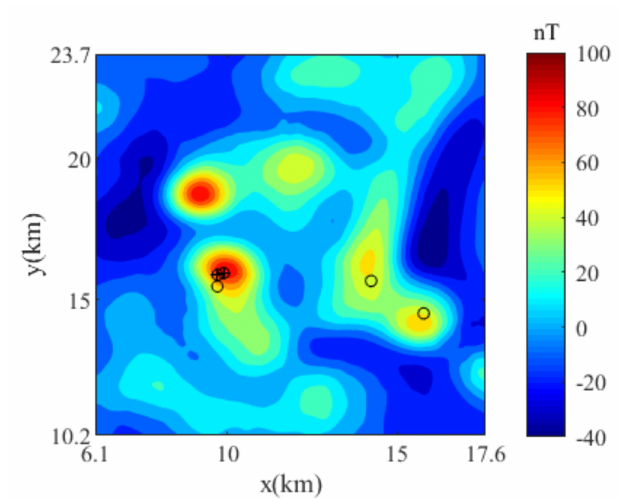
Figure 10. Locations of the boreholes and magnetite-caused anomalies in Litun Pluton subregion.